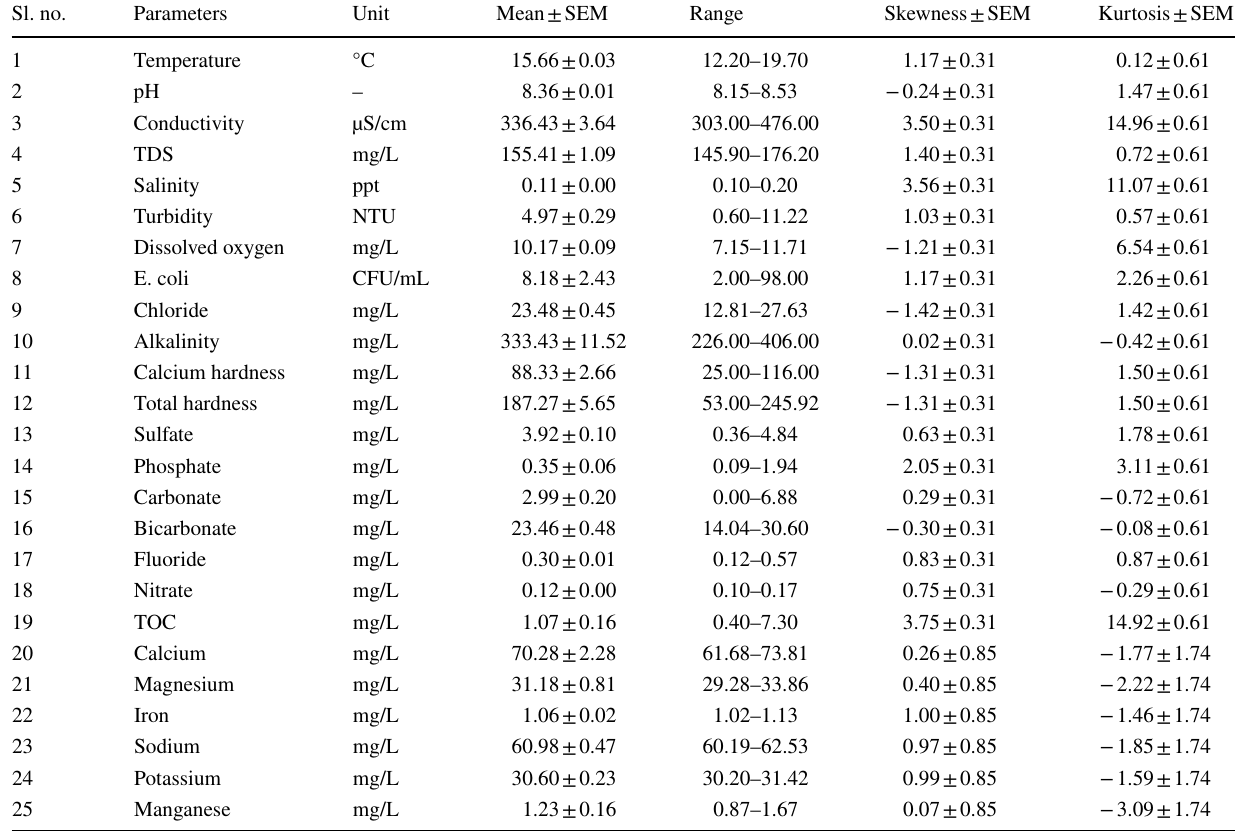
Table 4 General descriptive statistics of river water physicochemical and minerals of summer season Sl.